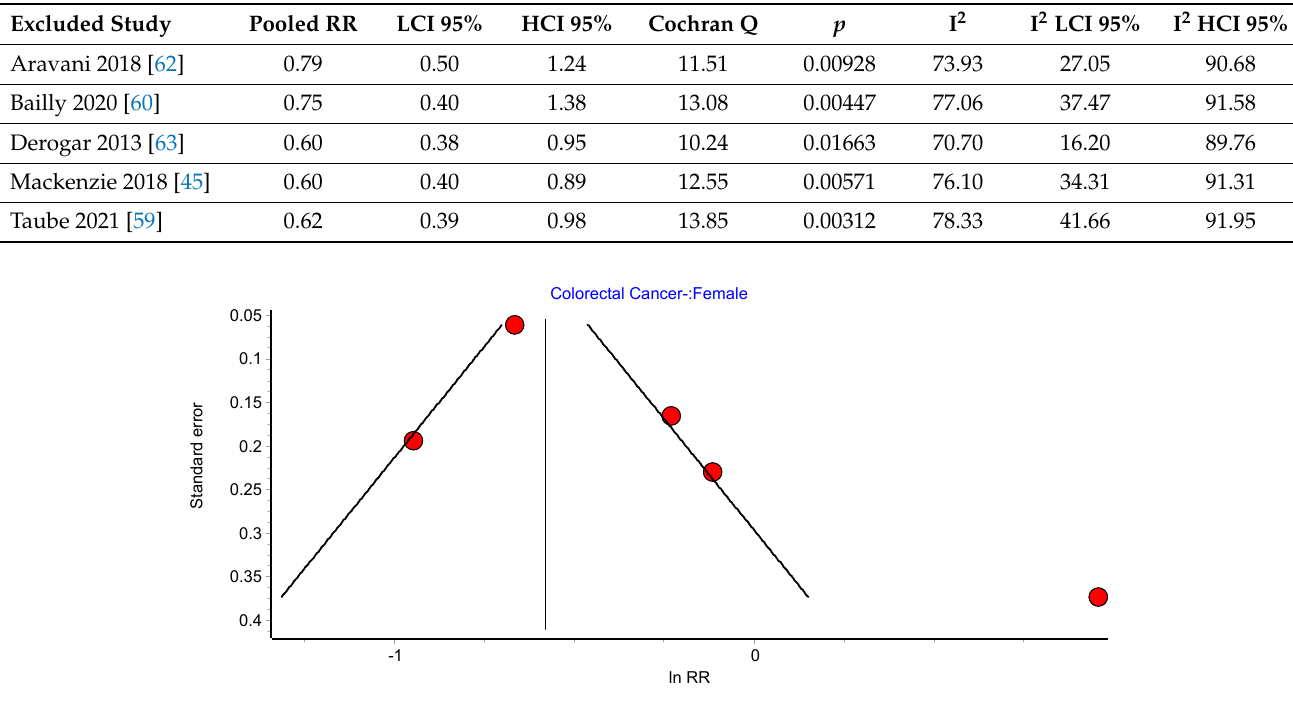
Figure A10. CRC male random effects model funnel plot. Table A10. CRC male random effects model sensitivity analysis.